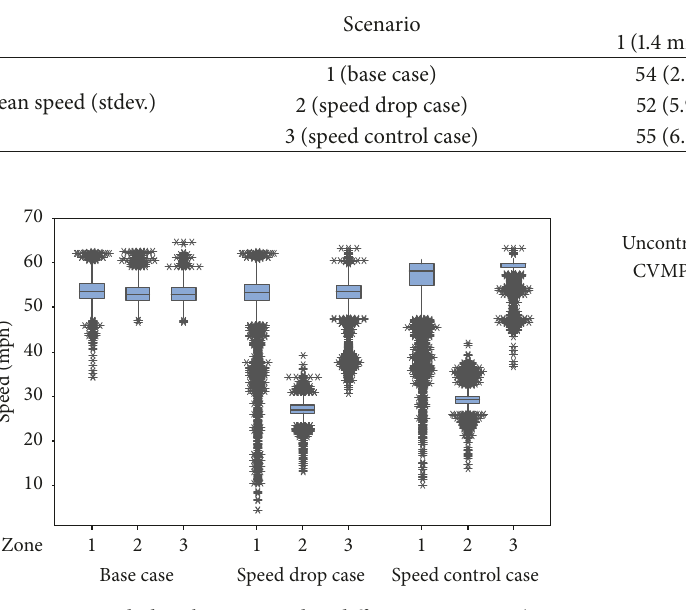
Figure 9: Speed distributions under different scenarios (100% market penetration).